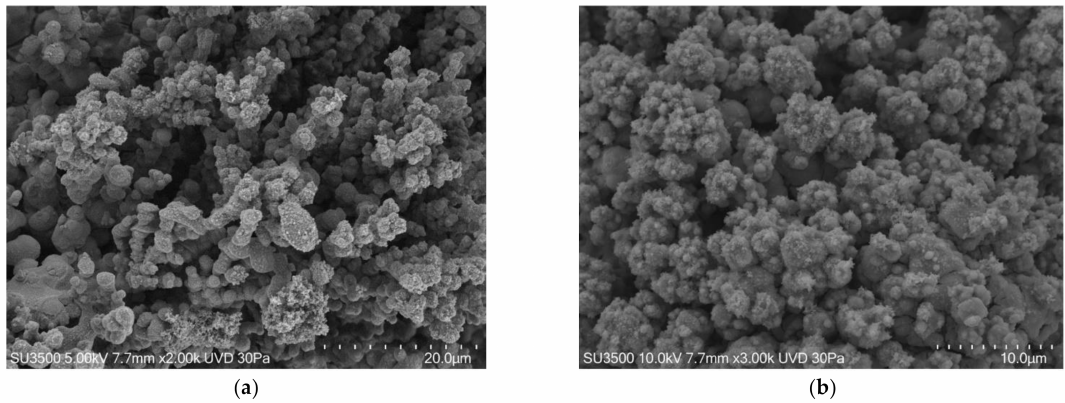
Figure 3. S. mutans prepared by conventional VP-SEM procedure. ( a ) VP-SEM 2000 × . An intricate micro-canalicular system develops among bacterial towers. Image was captured from the same sample observed in [50] Fig. ( b ) VP-SEM 3000 × . Hydration preservation confers biofilm a spongy aspect, without shrinking or any sign of collapse. Image was captured from the same sample observed in [50] Figure 2d.